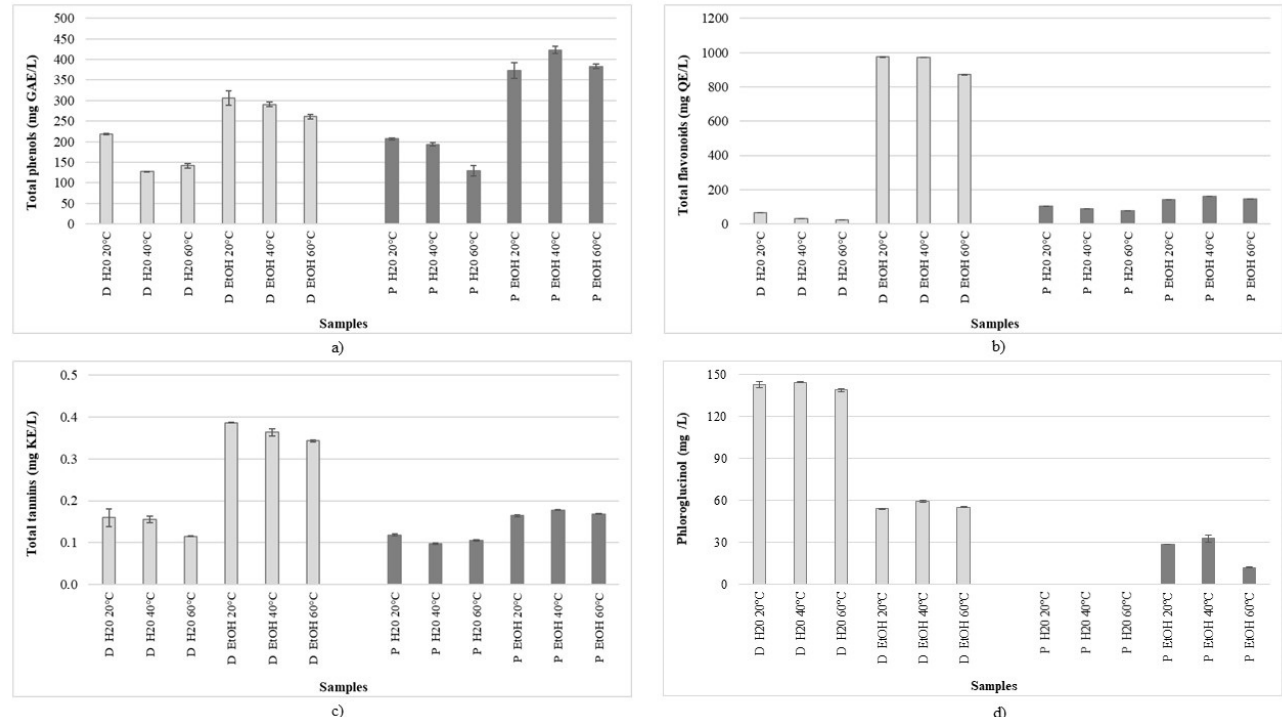
Figure 1. Total contents of ( a ) phenolics, ( b ) flavonoids, ( c ) tannins and ( d ) phloroglucinol in Dictyota dichotoma (D) and Padina pavonica (P) extracts.